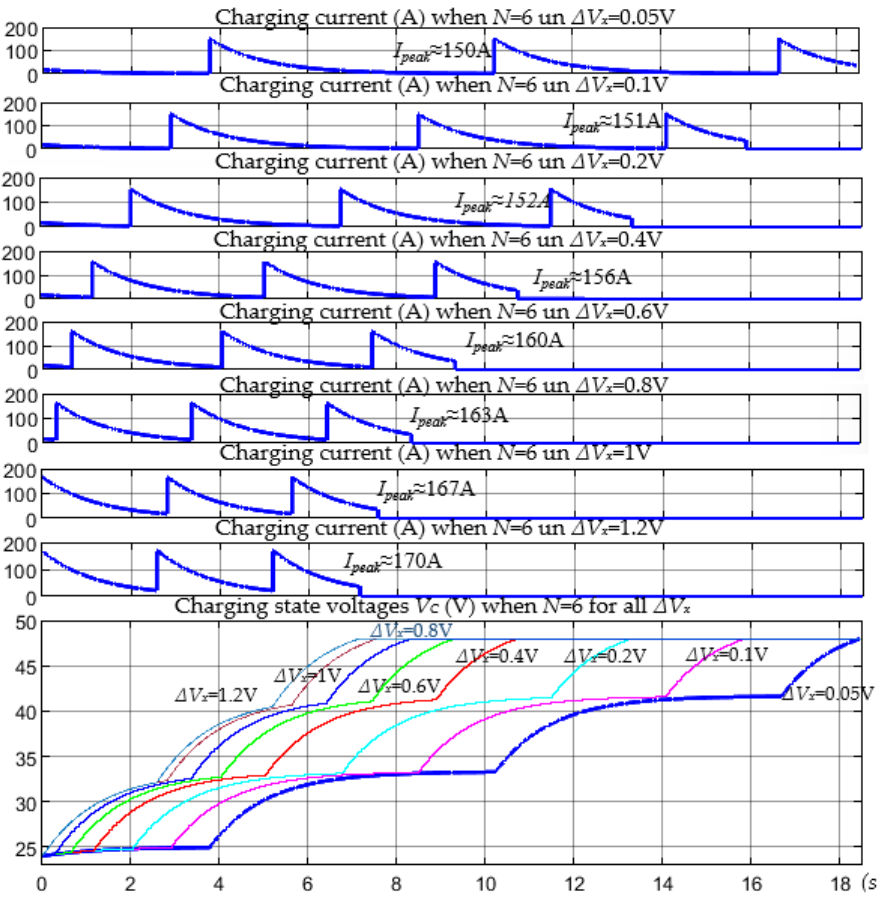
Figure 23. SC circuit charging current and voltage curves in the case of six phases at different ∆ V x.